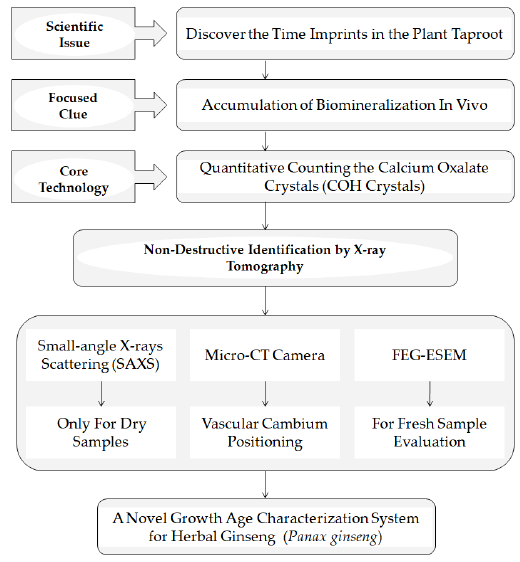
Figure 1. Research methodology of the study.